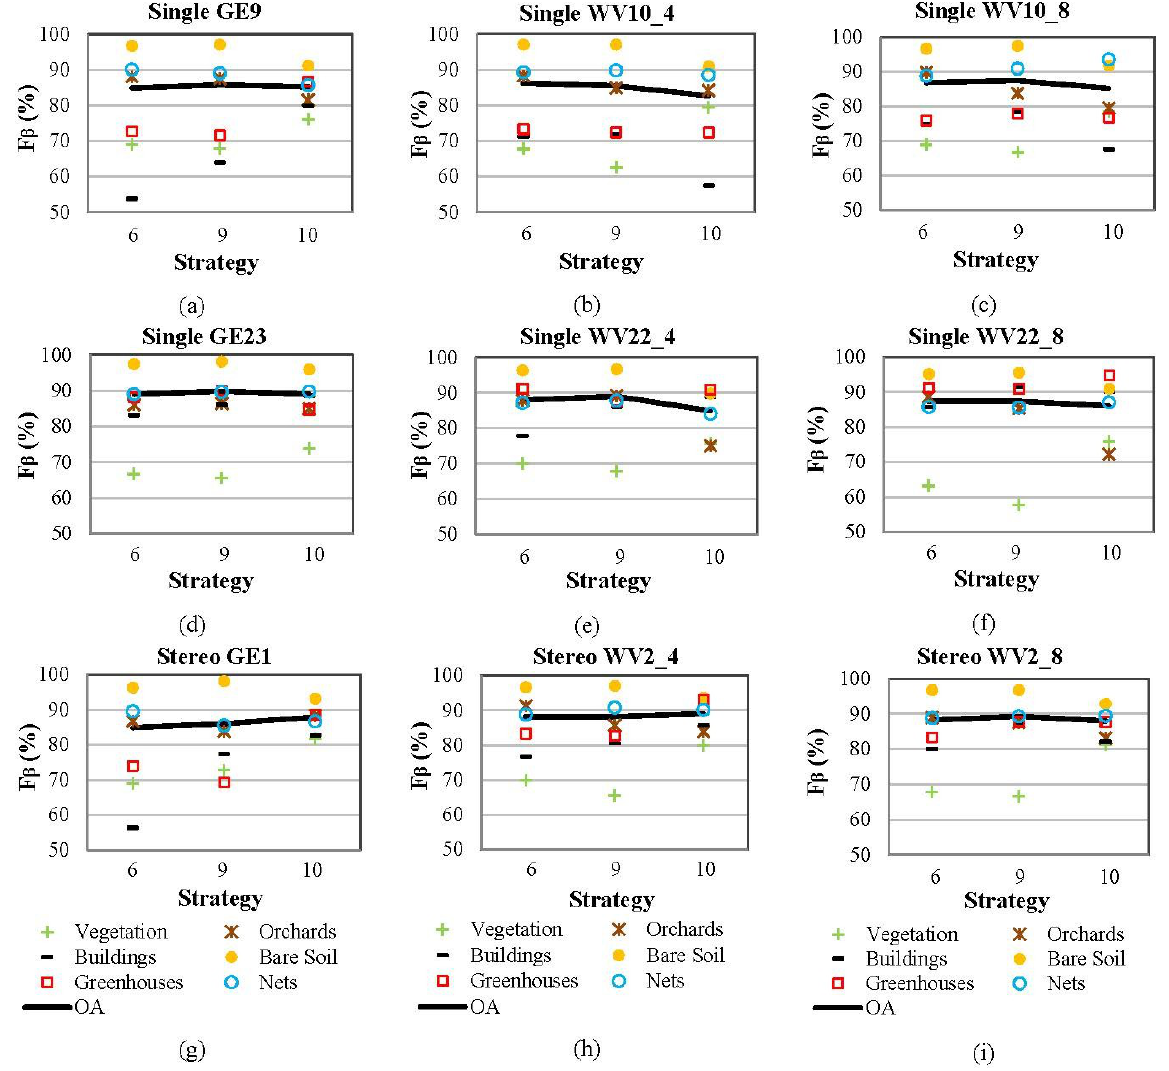
Figure 12. Per-class accuracy given by the corresponding F Strategies 6 (B + nDSM), 9 (B + BIs + nDSM) and 10 (All Features)). ( a ) Single GE9; ( b ) single WV10_4; ( c ) single WV10_8; ( d ) single GE23; ( e ) single WV22_4; ( f ) single WV22_8; ( g ) stereo GE1; ( h ) stereo WV2_4; ( i ) stereo